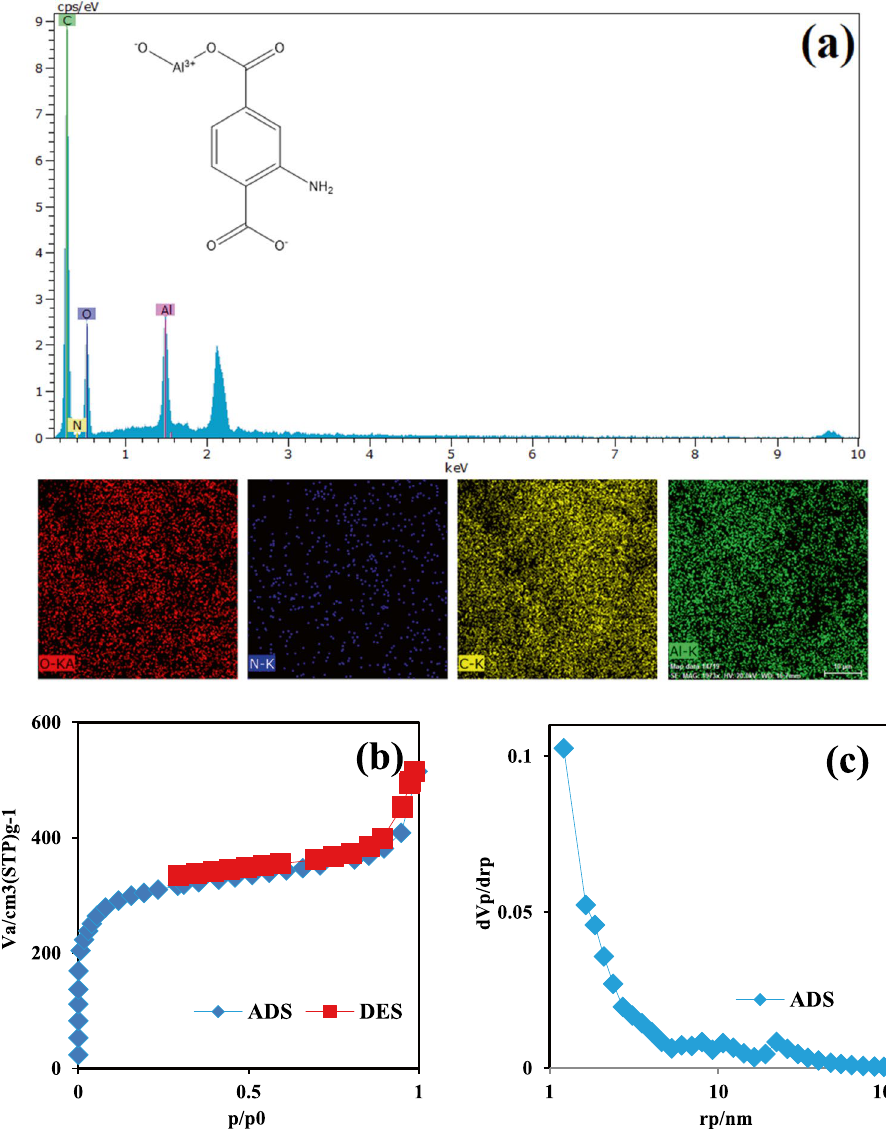
Figure 3. EDX-mapping analysis of amino-MIL-68(Al) ( a ). The ADS/DES isotherm of N 2 on amino-MIL- 68(Al) ( b ), BJH pore size of amino-MIL-68(Al) ( c